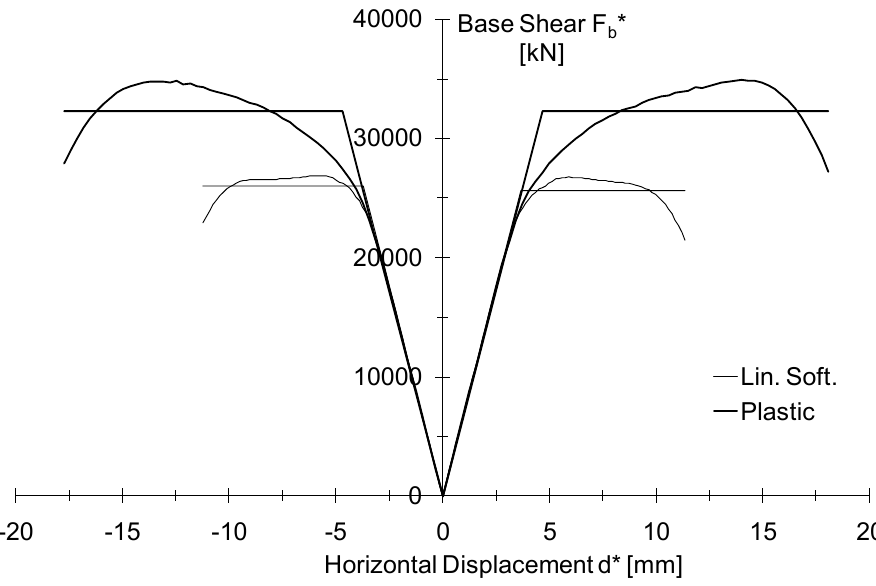
Figure 14. Capacity displacement curves of the structure normalized to Γ and of the SDOF equivalent system in direction ±X for the case of plastic behavior and linear softening under